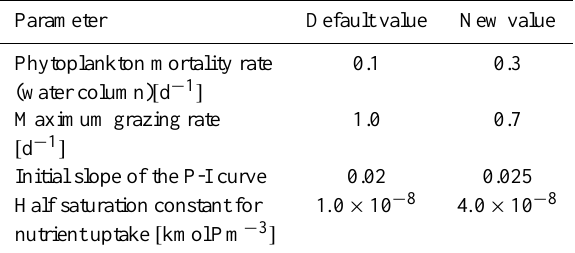
Table 1. Parameter setup of the NPZD model, default HAMOCC values (Ilyina et al., 2013) and new values after tuning to fit obser- vations close to Cape